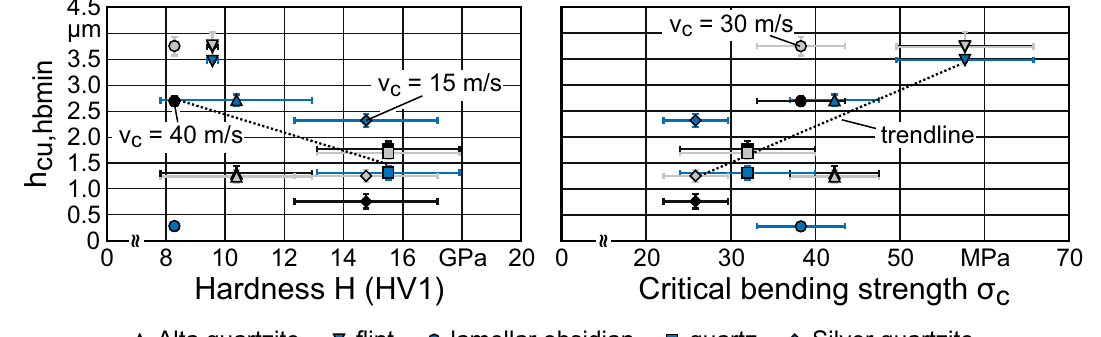
Fig. 11 Influence of hardness and critical bending strength on h